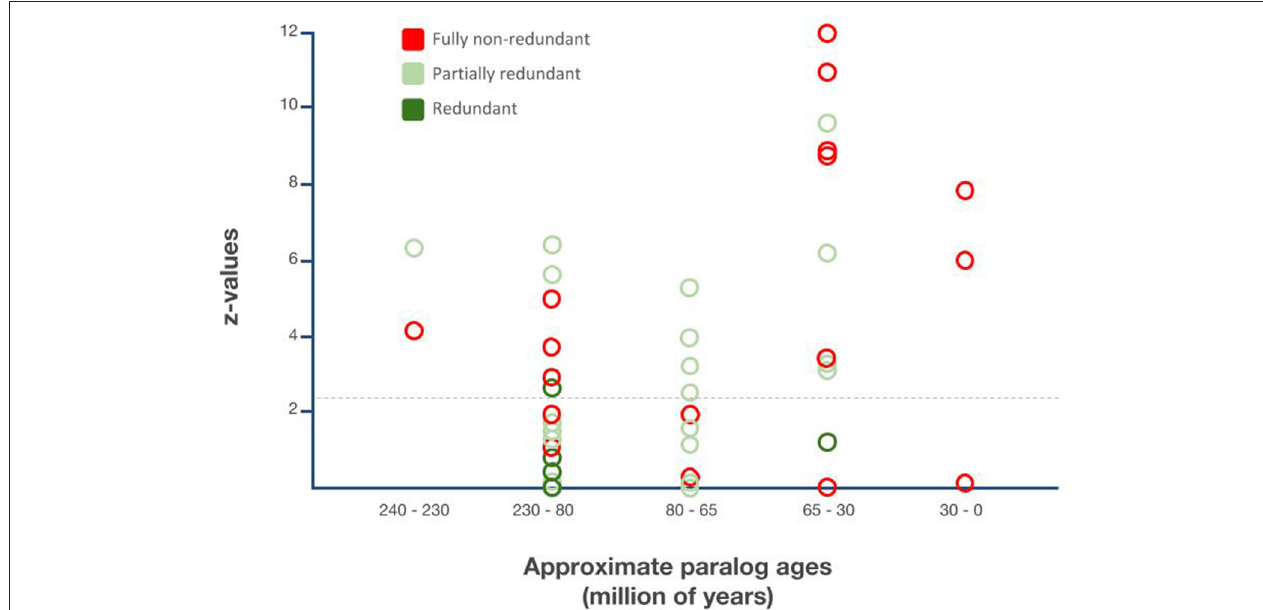
FIGURE 5 | Relationship between gene duplicate ages, functionalization trajectories, and asymmetric paralog evolution in the Drosophila lineage-specific gene duplicates. X-axis: Sister paralog age classes based on Figure 4 . Y-axis: Extent of relative sequence divergence of sister paralogs as reflected by relative rate test z-values obtained from relative rate tests with PHYLTEST 2.0 (Kumar, 1996). Hatched horizontal line indicates p < 0.05 significance threshold level after correction for multiple testing applying the Benjamini & Hochberg False Discovery Rate (FDR) correction (Benjamini and Hochberg, 1995).